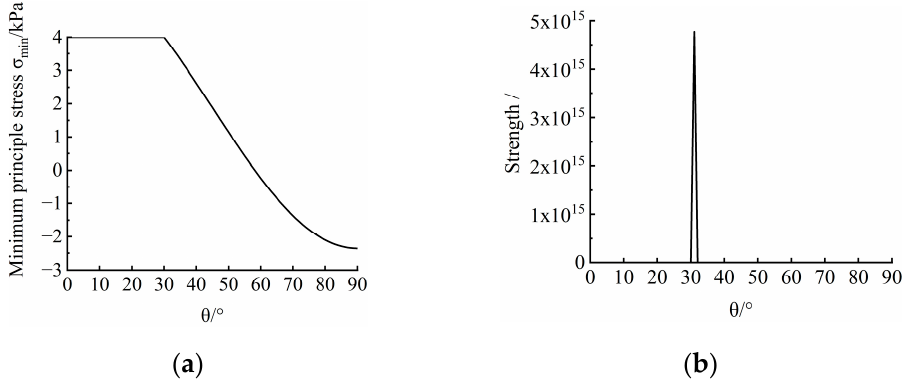
Figure 9. Phase Ⅰ ( β ≈ 30°). ( a ) Distribution of minimum principal stress; ( b ) distribution of Figure 9. Phase I ( β ≈ 30 ◦ ). ( a ) Distribution of minimum principal stress; ( b ) distribution of strength. strength.